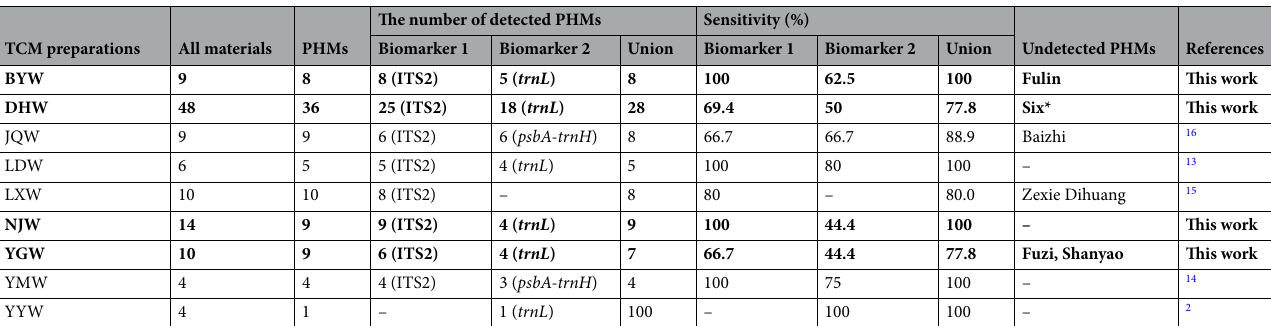
Table 8. Comparison of the sensitivity of prescribed herbal materials through detected prescribed herbal species of TCM preparations. Note that we only calculated the sensitivity of prescribed herbal materials of TCM preparation samples bought from manufacturers. The bold contents are the research targets of this work, others are from the previously published studies. *The six undetected PHMs of DHW were Arisaematis rhizome (Tiannanxing), Aucklandiae radix (Muxiang), Olibanum (Ruxiang), Citri reticulatae pericarpium viride (Qingpi), Draconis sanguis (Xuejie), Drynariae rhizome (Gusuibu), Caryophylli flos (Dingxiang), Polygoni multiflori radix (Heshouwu), Puerariae lobatae radix